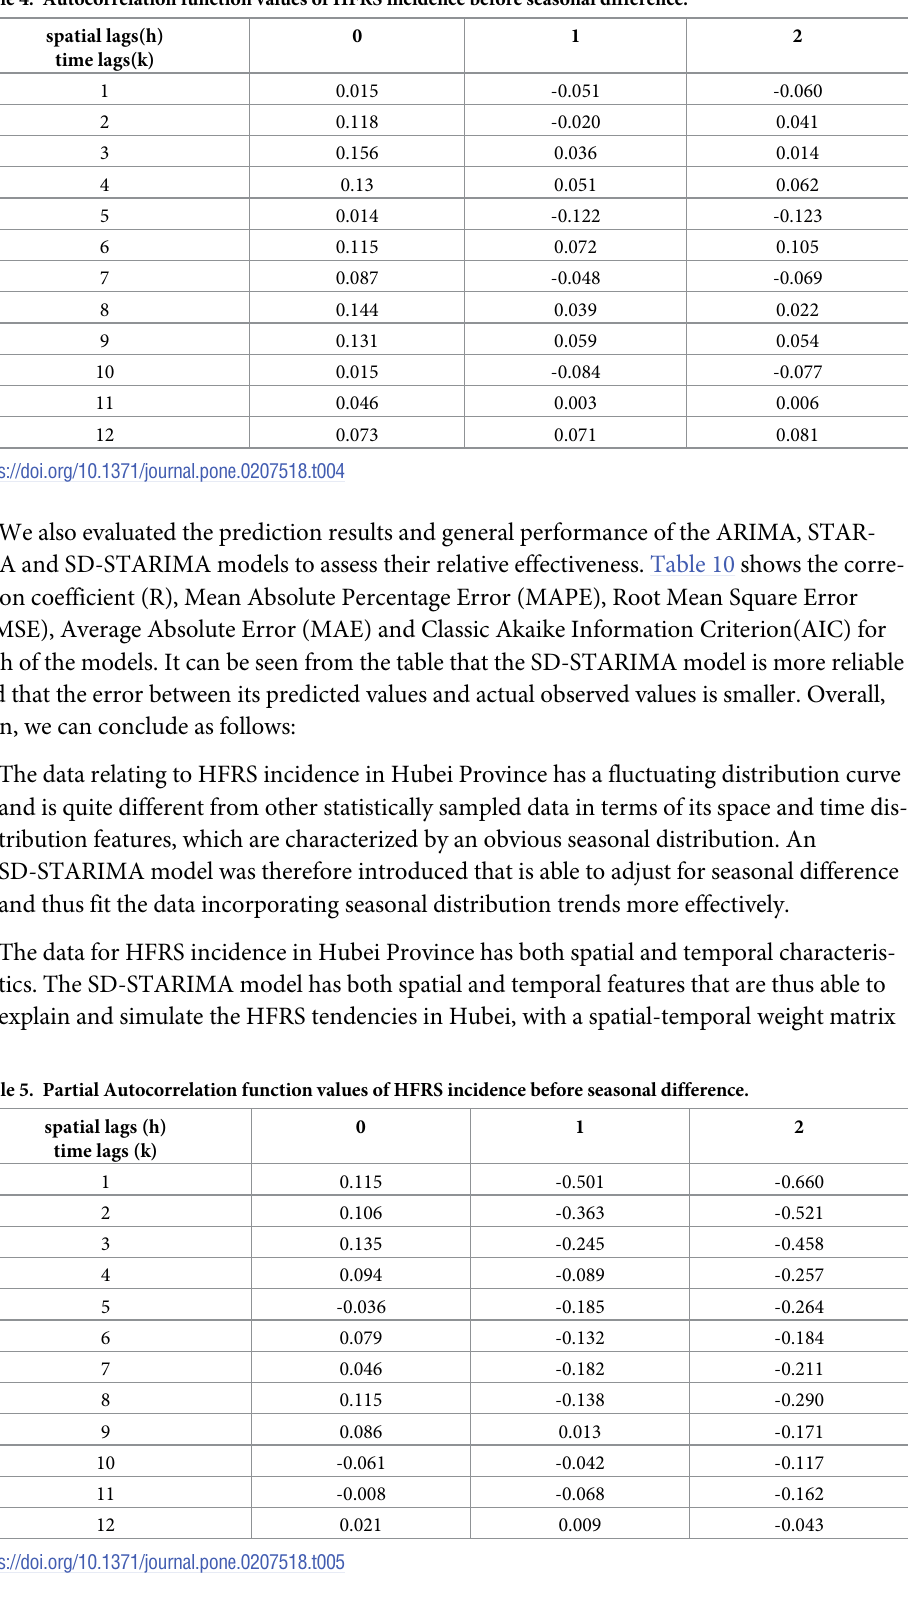
Table 4. Autocorrelation function values of HFRS incidence before seasonal difference.